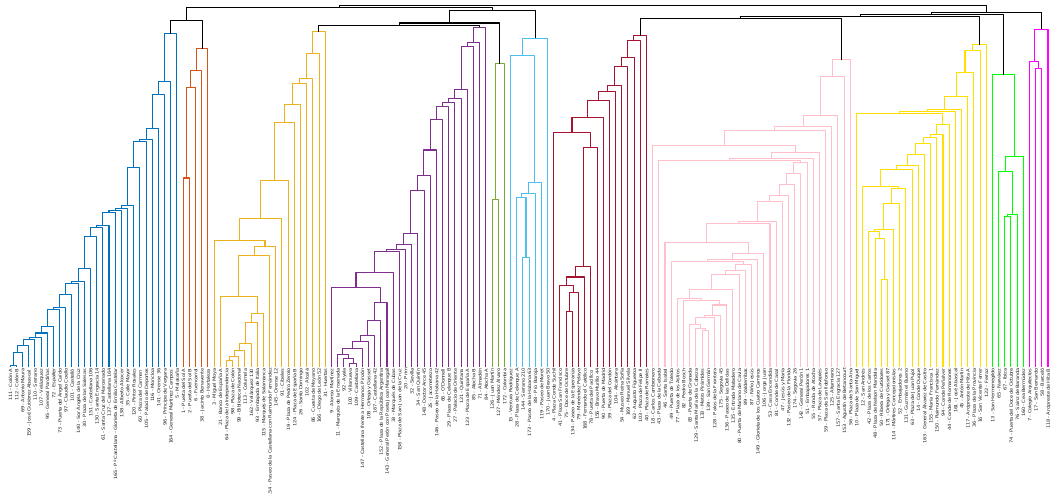
Figure 1. Dendrogram (binary tree). Groups numbered from left to right: g#1 (dark blue), 28 stations; g#2 (red), 5 stations; g#3 (orange), 19 stations; g#4 (purple), 26 stations; g#5 (dark green), 3 stations; g#6 (light blue), 7 stations; g#7 (garnet), 16 stations; g#8 (light pink), 33 stations; g#9 (gold yellow), 22 stations; g#10 (light green), 6 stations; g#11 (dark pink), 4 stations.